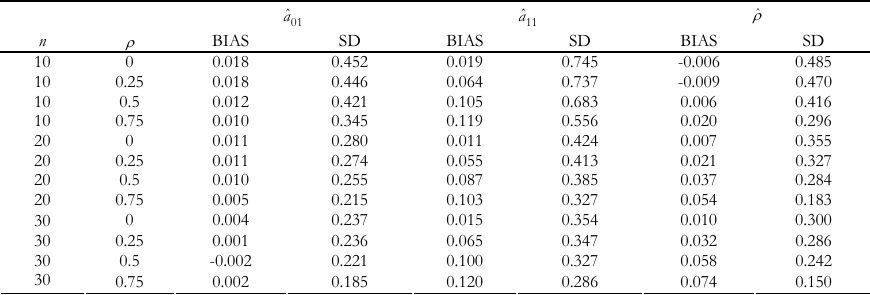
Synthesized results of the simulation referred to the simplified procedure based on ordered medians: N =1000, r = 1 01 ˆ a